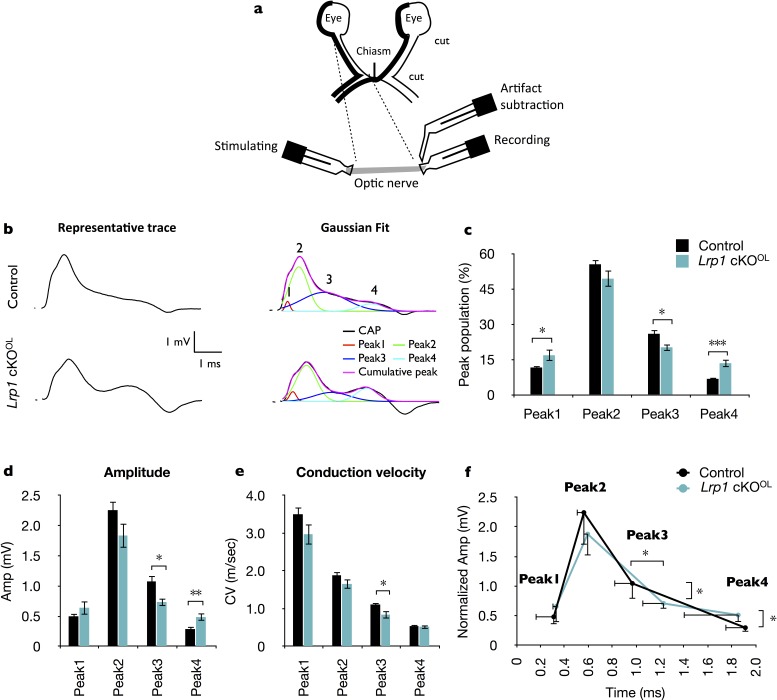
Loss of Lrp1 in the OL lineage leads to faulty optic nerve conduction.(a) Scheme depicting the orientation of an optic nerve prepared for compound action potential (CAP) recordings. Positions of the stimulating electrode, the recording electrode, and artifact subtraction electrode are shown. (b) Left: representative raw CAP traces of P21 optic nerves. Right: For each recording, traces were fitted with four Gaussians representing peak 1 (red), peak 2 (green), peak 3 (blue), peak 4 (cyan), and the sum of the four peaks (magenta). (c) The distribution of peak populations in Lrp1 control and cKOOL mice. (d) Quantification of amplitudes (mV) of peaks 1, 2, 3, and 4 in Lrp1 control and cKOOL optic nerves. (e) Quantification of conduction velocities (m/sec) of peaks 1, 2, 3, and 4 in Lrp1 control and cKOOL optic nerves. (f) Reconstituted averaged peaks 1–4 amplitude as a function of time. Lrp1 control (n = 21 nerves/14 mice) and cKOOL (n = 9 nerves/7 mice). Results are presented as the mean ±SEM, *p<0.05, **p<0.01, and ***p<0.001, Student’s t-test. For a detailed statistical report, see Figure 2—source data 1.